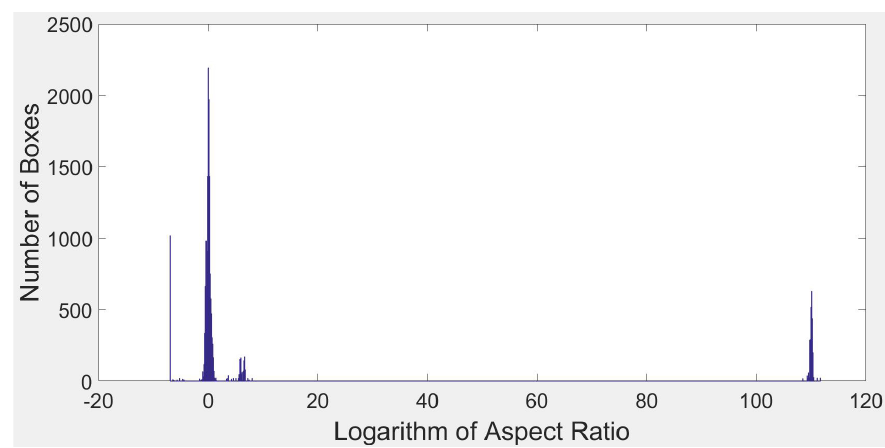
Figure 5. Aspect ratio of region proposed by deformable